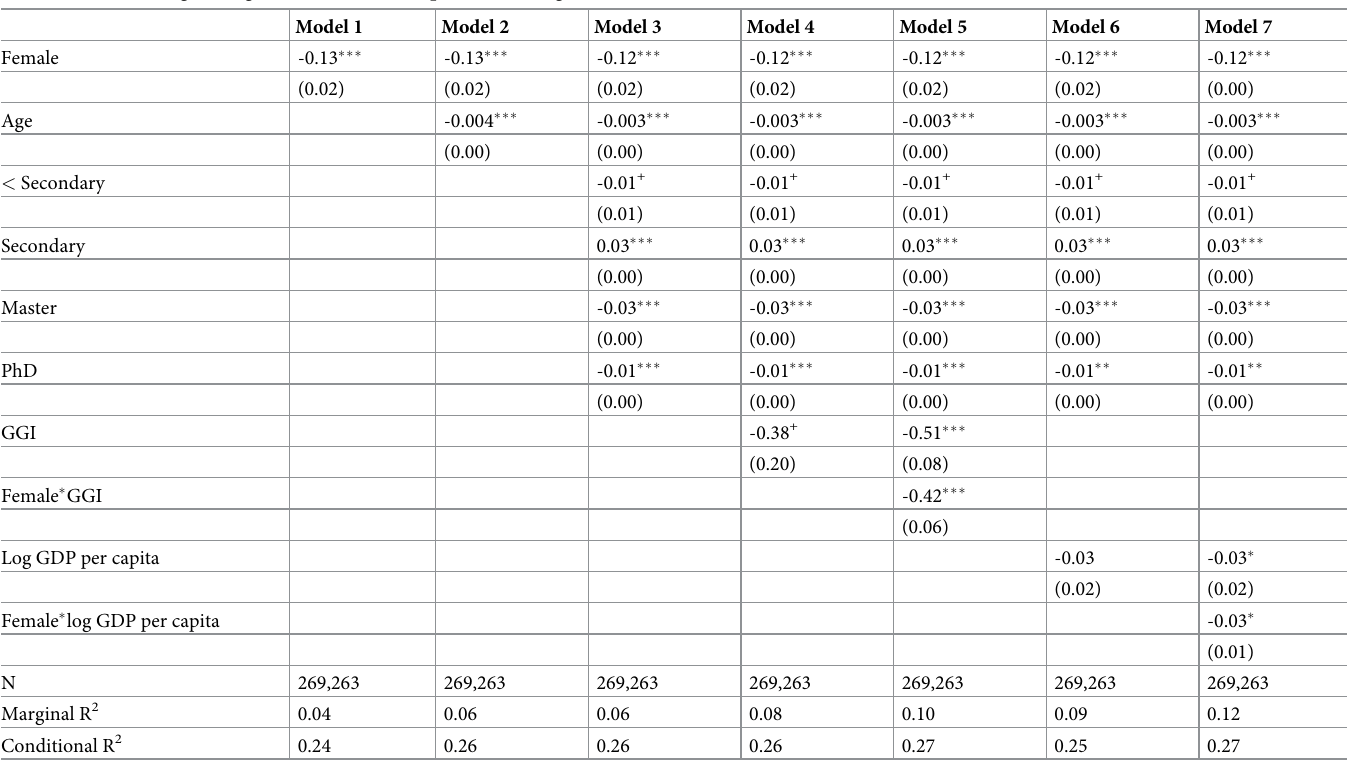
Table 2. Multilevel logistic regression on whole sample for enrolling in STEM